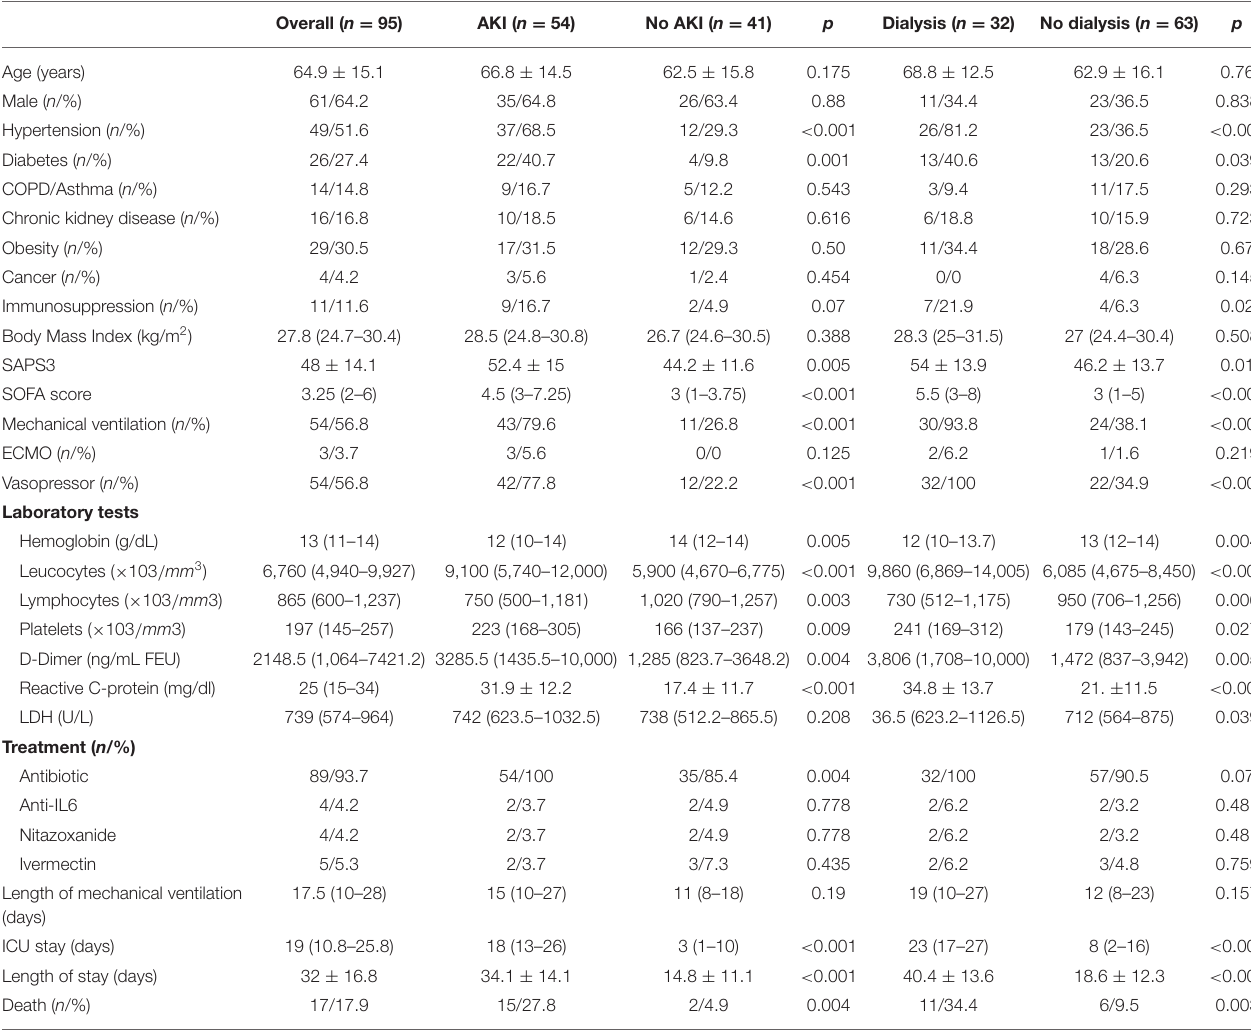
TABLE 1 | Comparative clinical data, laboratory tests, and treatment in patients who presented with acute kidney injury and need of dialysis. Overall ( n = 95) AKI ( n =